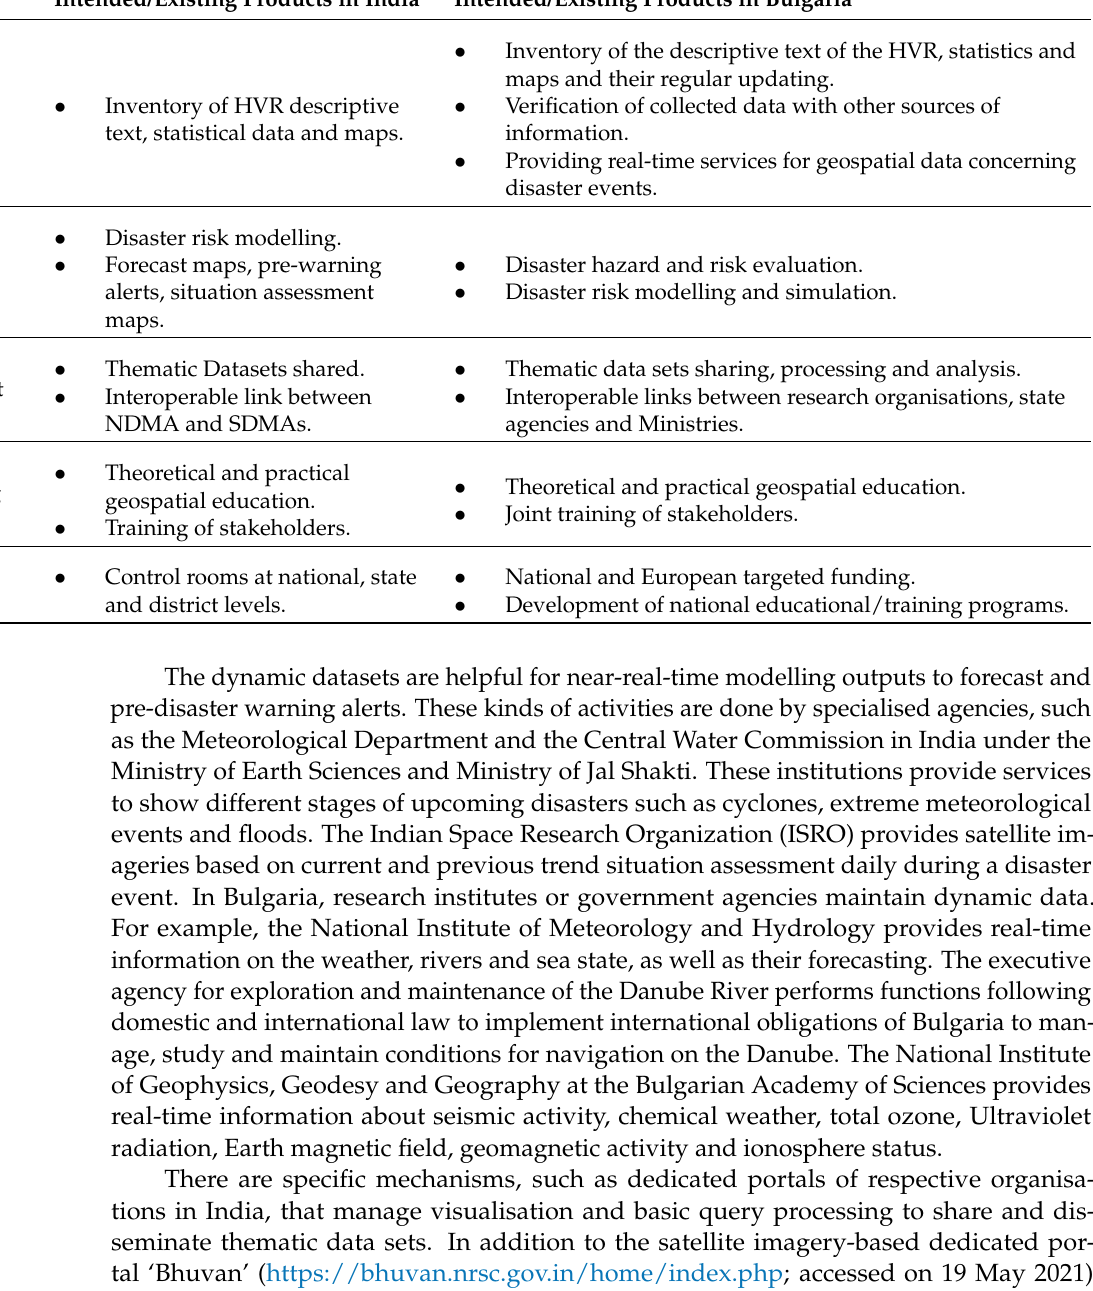
Table 5. Comparative geospatial data/information content of the organisational responsibilities of India and Bulgaria.